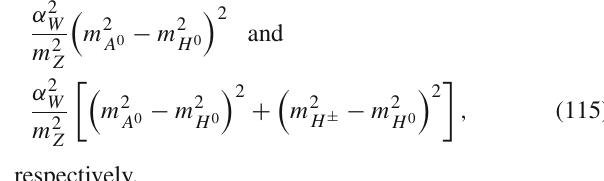
Fig. 23 Summary of constraints for the IDM model in the light DM mass regime, in the bi-dimensional plane ( m H 0 , | λ L | ) for λ L >0 (upper panel) and λ L < 0 (lower panel). The color coding is the same as used for the SM Higgs portal model in Sect. 7: the red curve represents the iso-contour of the correct DM relic density. The blue, magenta and purple regions are, respectively, the XENON1T excluded region and the projected exclusions by XENON1T (assuming 2 years of exposure time)andLZ.The brown region isexcludedby thecurrent experimental determination of the SM Higgs invisible branching